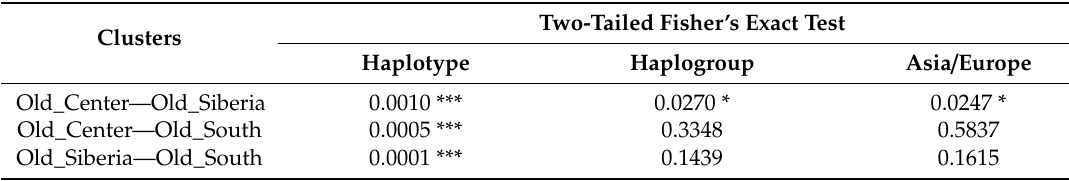
Table 6. Two-tailed Fisher’s exact test in Old group